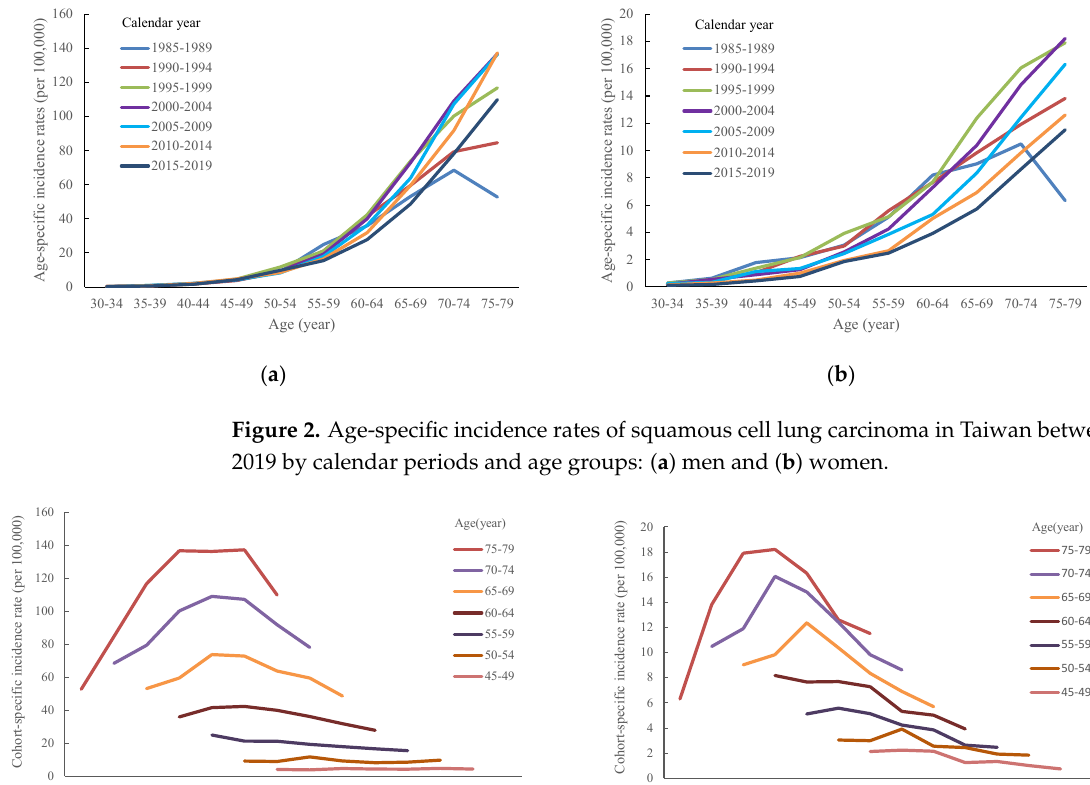
Figure 2. Age-specific incidence rates of squamous cell lung carcinoma in Taiwan between 1985 and 2019 by calendar periods and age groups: ( a ) men and ( b ) women. Figure 3. Cohort-specific incidence rate of squamous cell lung carcinoma in Taiwan between 1985 and 2019 by age groups: ( a ) men and ( b ) women.